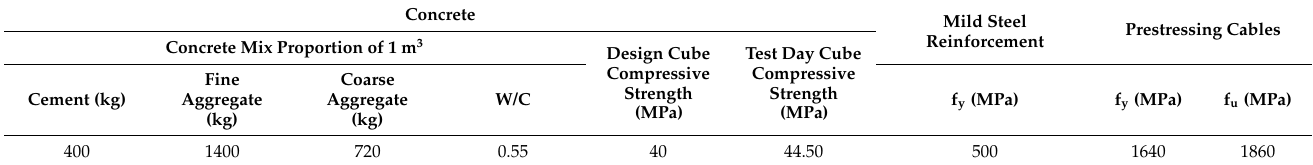
Table 2. Material characteristics of tested flat